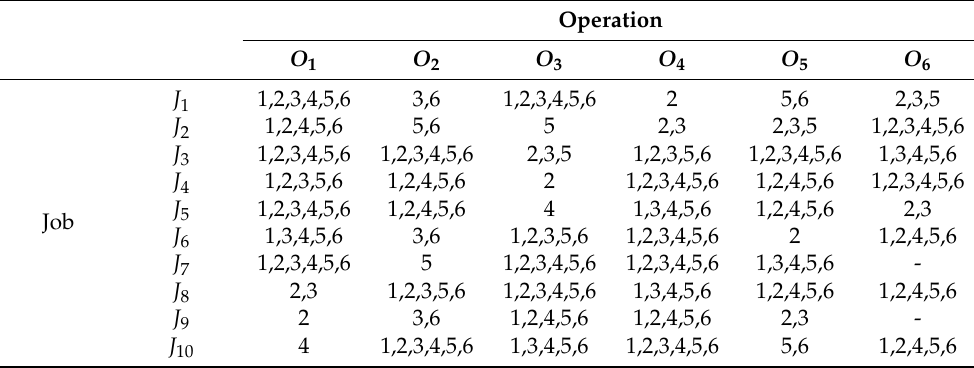
Table 10. Machines corresponding to each operation of MK2.